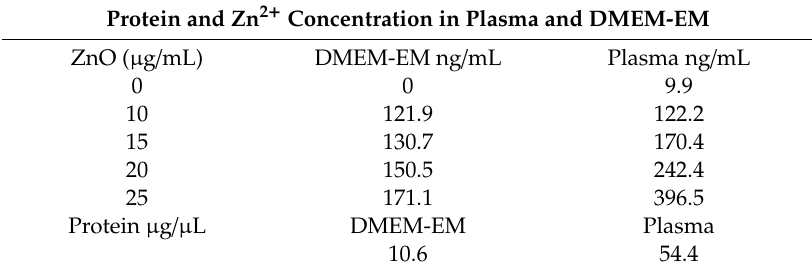
Table 1. The amount of soluble zinc ions in DMEM-EM and plasma independent of the different ZnO- NP concentrations. Furthermore, the protein concentration is pictured in the table as well.